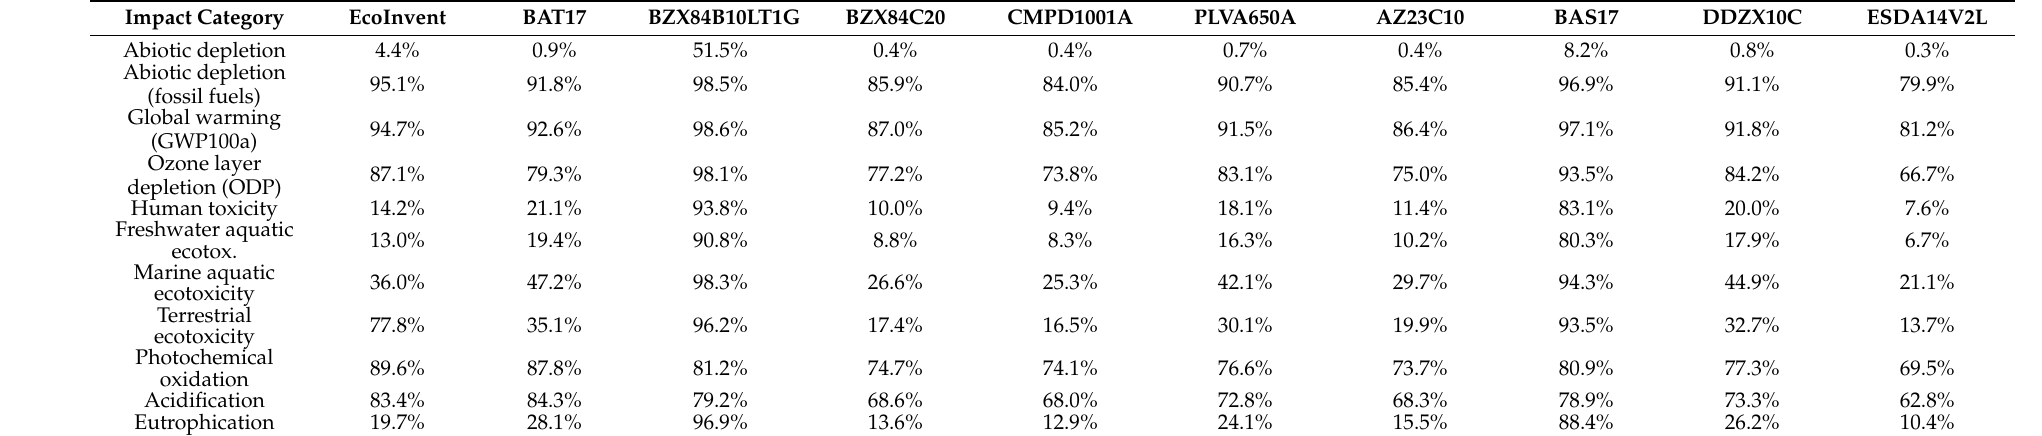
Table 5. Percentage of environmental impact created due to part